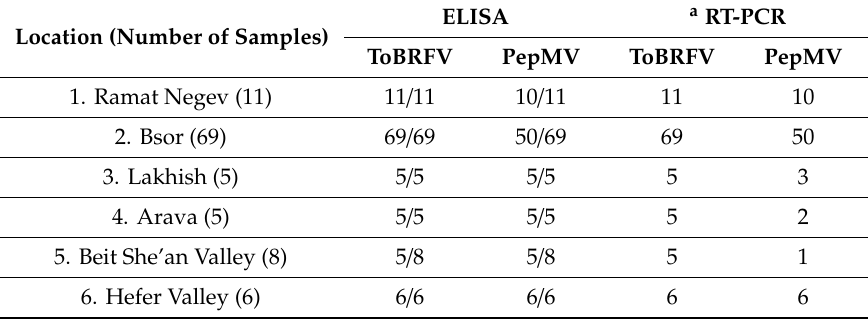
Table 2. Viral analyses of tomato plants collected from 104 greenhouse tomato plots in Israel, using enzyme-linked immunosorbent assay (ELISA) and RT-PCR. ELISA a RT-PCR Location (Number of Samples) ToBRFV PepMV ToBRFV PepMV 1. Ramat Negev